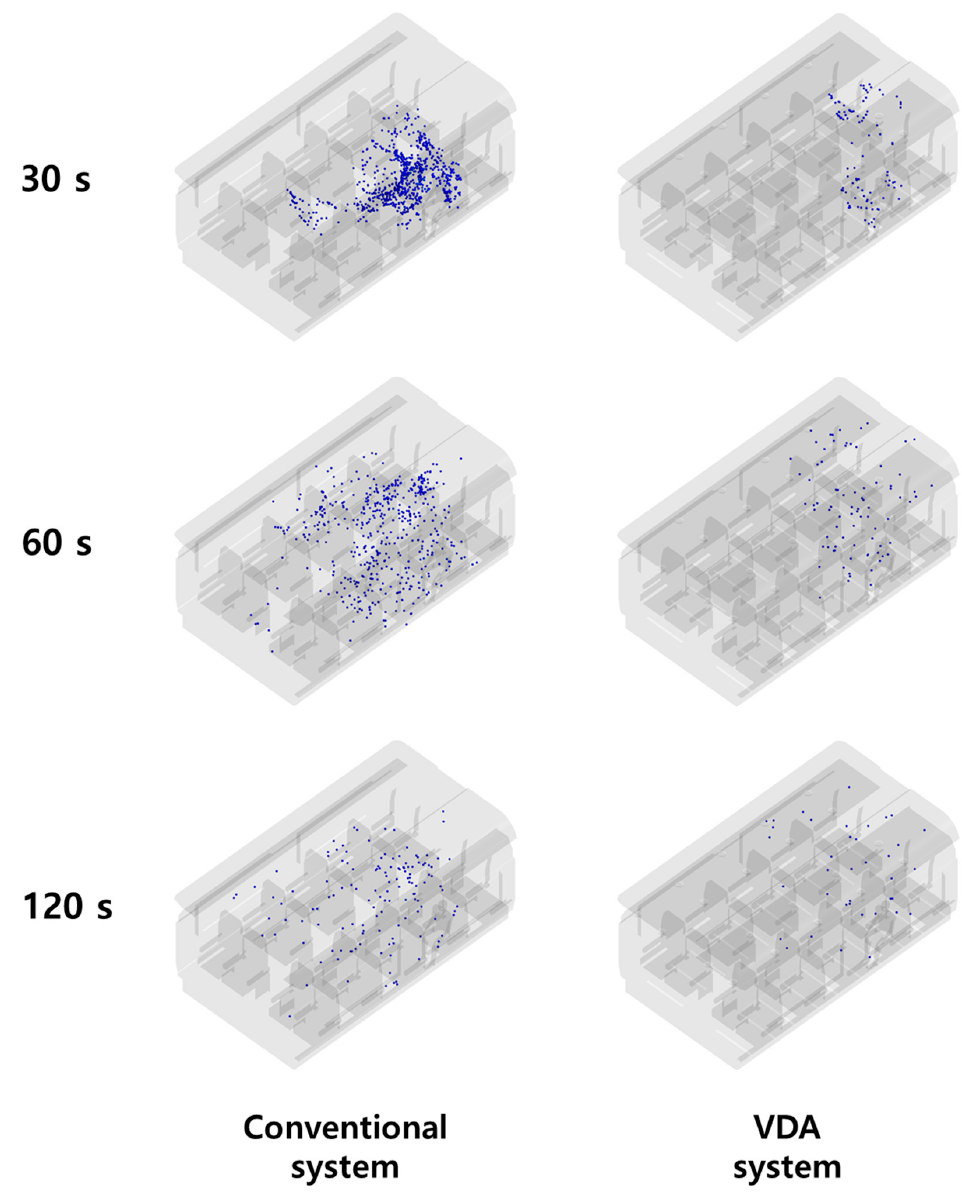
Figure 10. Droplet distributions in the conventional and VDA systems between 30 and 120 s after coughing. The droplet size is uniform.